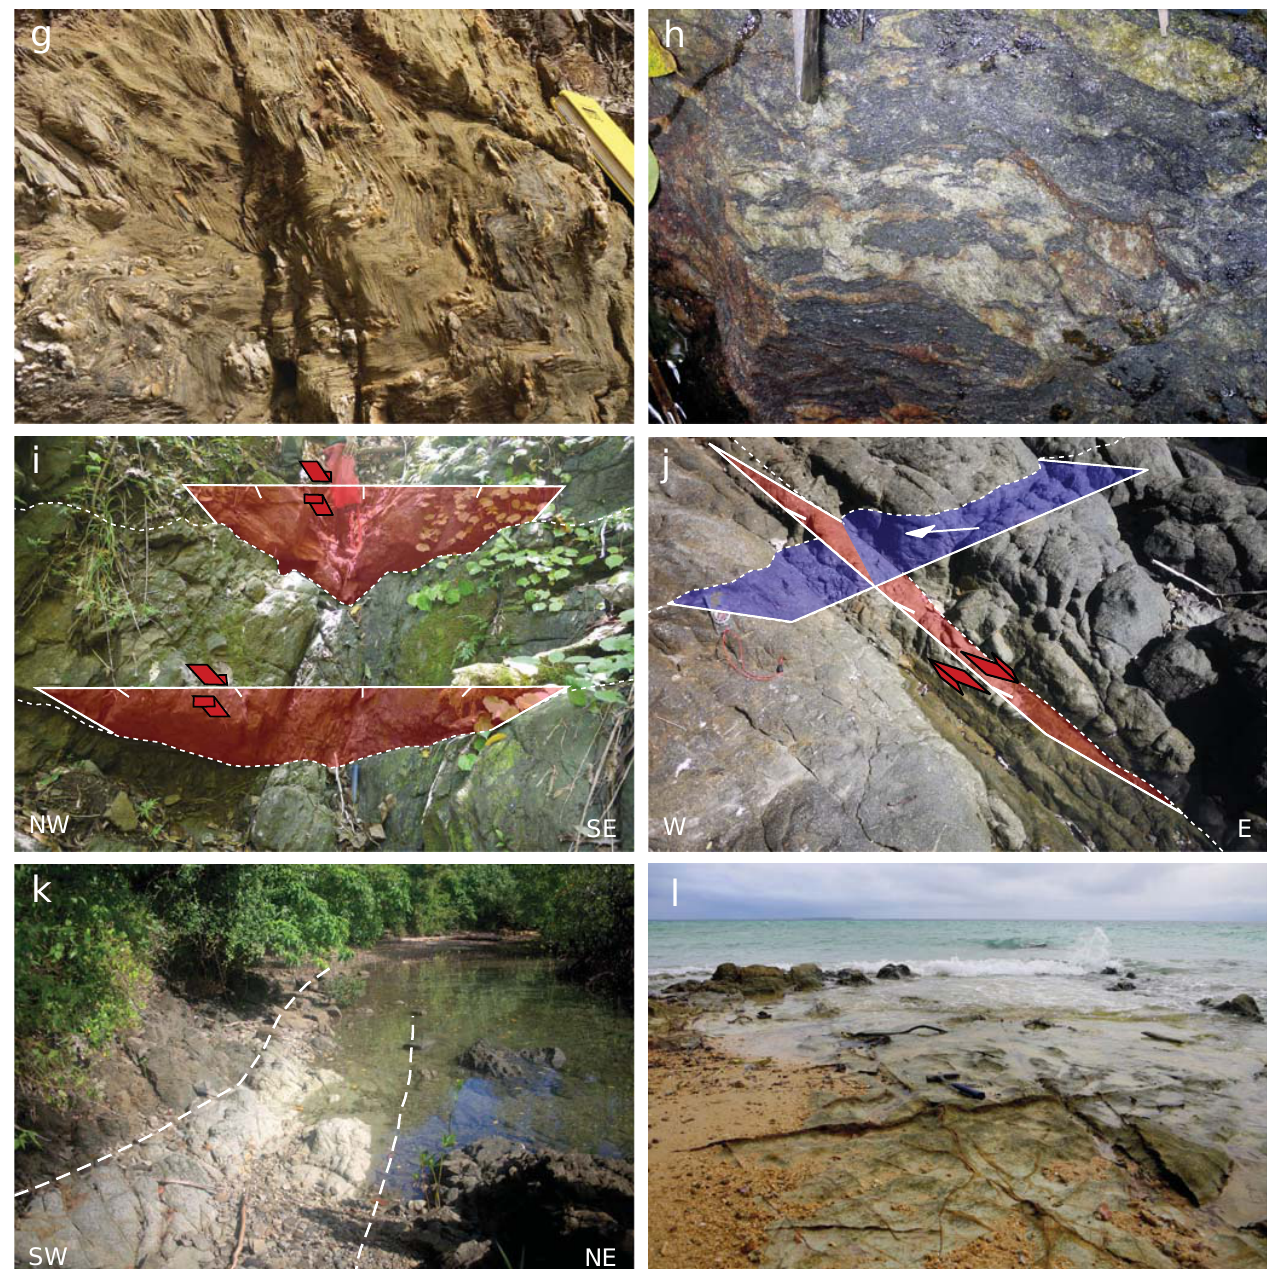
Fig. 7. Continued. Field relations on the Kaibobo Peninsula. (g) Tightly folded mica schists of the Tehoru Formation on Tanjung Tutu- naten (128.1717 ◦ E, 3.1402 ◦ S); (h) Metatexites of the Taunusa Complex metamorphic-migmatitic overprint (128.1924 ◦ E, 3.1708 ◦ S); (i) Faults within peridotites lying just beneath and oriented parallel to the Kaibobo Detachment (128.1765 ◦ E, 3.1755 ◦ S); (j) Mylonitised cordierite granites of the Tanjung Motianai shear zone. Mylonitic foliation (blue plane; 232/28N) and lineation (white arrow; 12/258) are indicated, which have been cut by steep normal faults (red plane; 300/55N) that have been exploited by haematite mineralisation (128.2024 ◦ E, 3.2173 ◦ S); (k) Gabbro dyke intruded through mylonitised granite on Tanjung Motianai (128.2022 ◦ E, 3.2172 ◦ S); (l) Criss- crossing haematite veins through sandstone on Tanjung Totuhur, Pulau Babi (128.1553 ◦ E, 3.2313 ◦